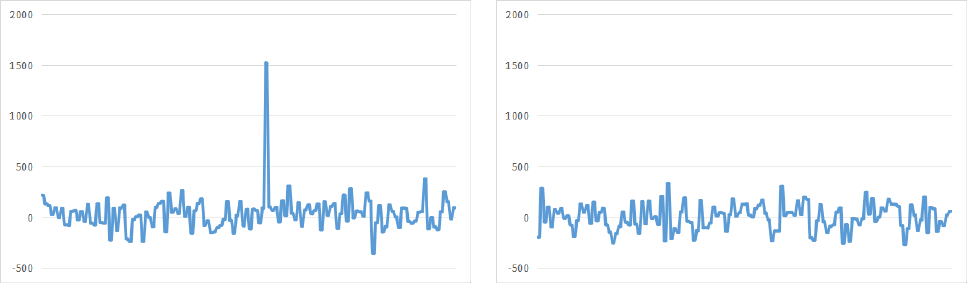
Figure 3: The Walsh Spectrum of the func- tion h s for the correct guess of S 0 c